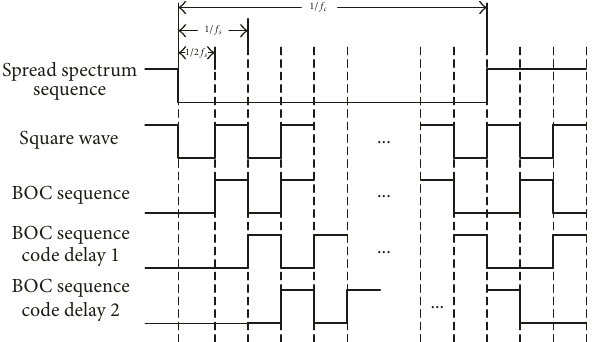
Figure 3: The generation process of the autocorrelation